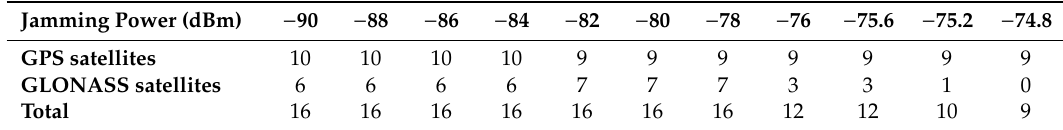
Table 6. Minimum number of available satellites for scenario #3.